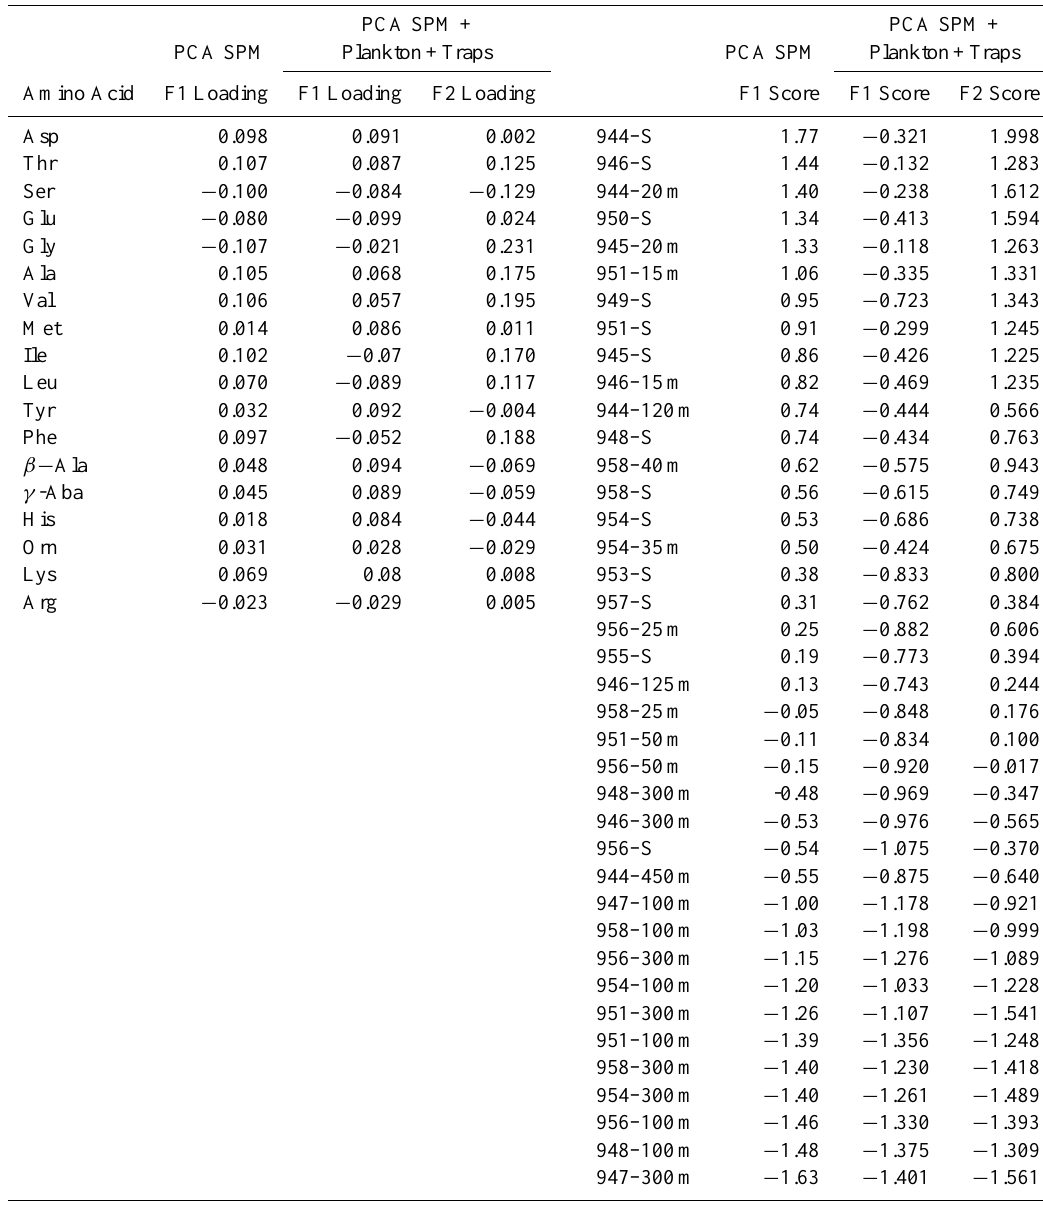
Table 2. Factor loadings of individual AAs of a PCA carried out with all analysed amino AAs in Mol% of all SPM samples and a PCA of Mol% of all AAs carried out of SPM, plankton and trap samples (data in Supplement 2). Factor scores of individual SPM samples of the two PCAs sorted by the factor scores of the first factor (F1) of the PCA of SPM only. The sorting is very similar to that of the factor F2 of the PCA which includes SPM, plankton and trap samples (see text for